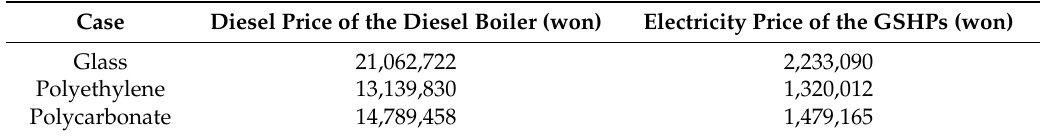
Table 9. Annual operation costs of each case.